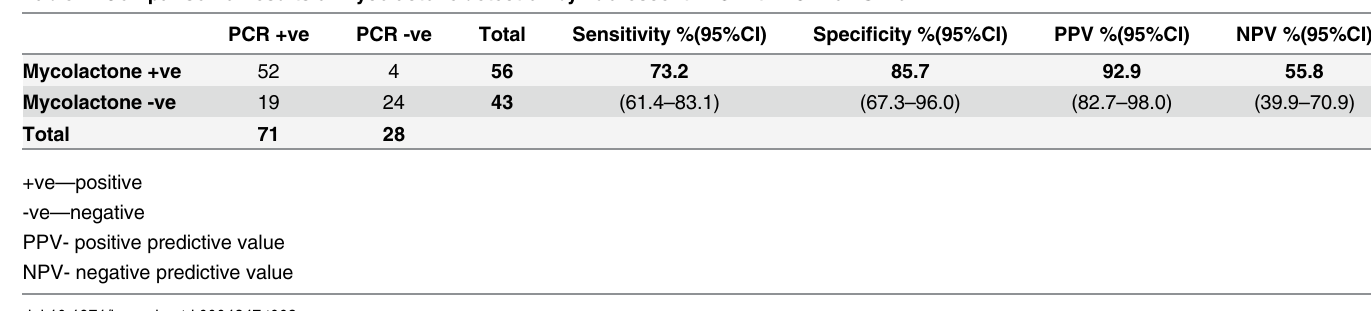
Table 2. Comparison of results of mycolactone detection by fluorescent TLC with PCR for IS2404